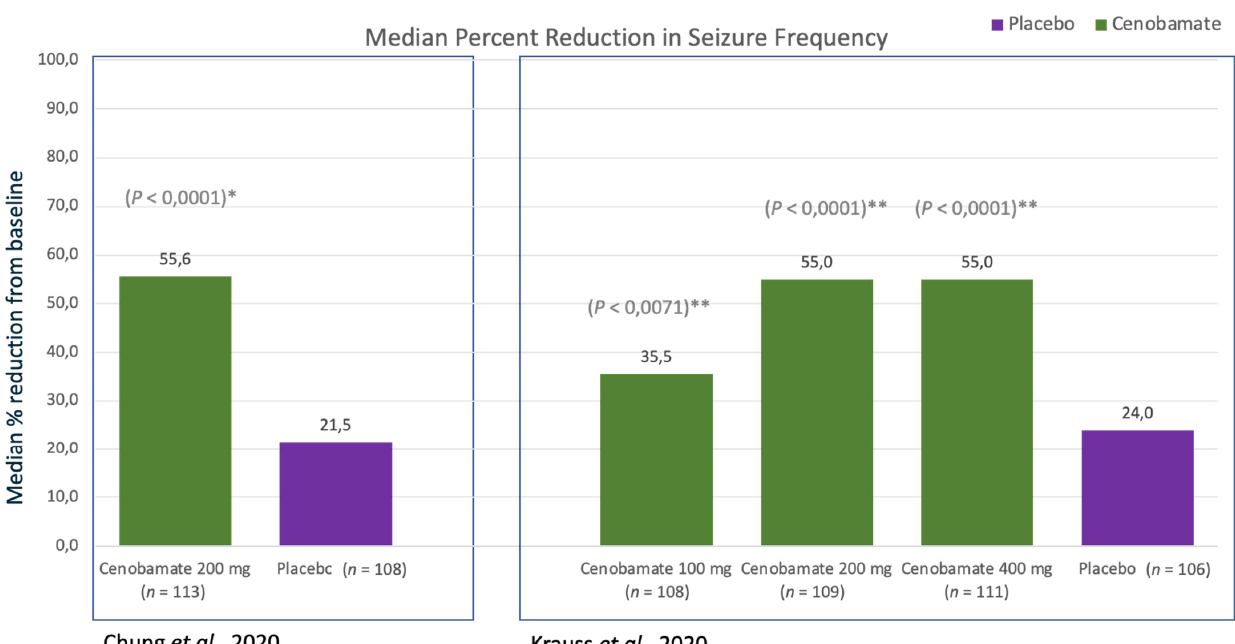
Figure 3. Efficacy data showed as median percentage reduction in seizure frequency from randomised, controlled, double- blind trials [4,5]. * 12-Week treatment period (6-week titration + 6-week maintenance phase), ** 18-Week treatment period (6-week titration + 12-week maintenance phase)